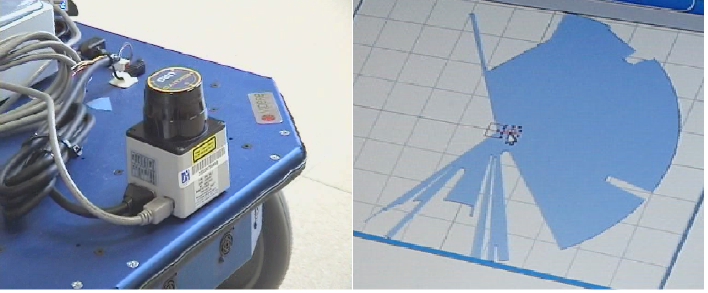
Figure 9. Hokuyo URG-04LX laser rangefinder sensor used for pattern tracking and following (left). Beam pattern emitted by the sensor and example of range measurement done in a complete 240 ◦ scan